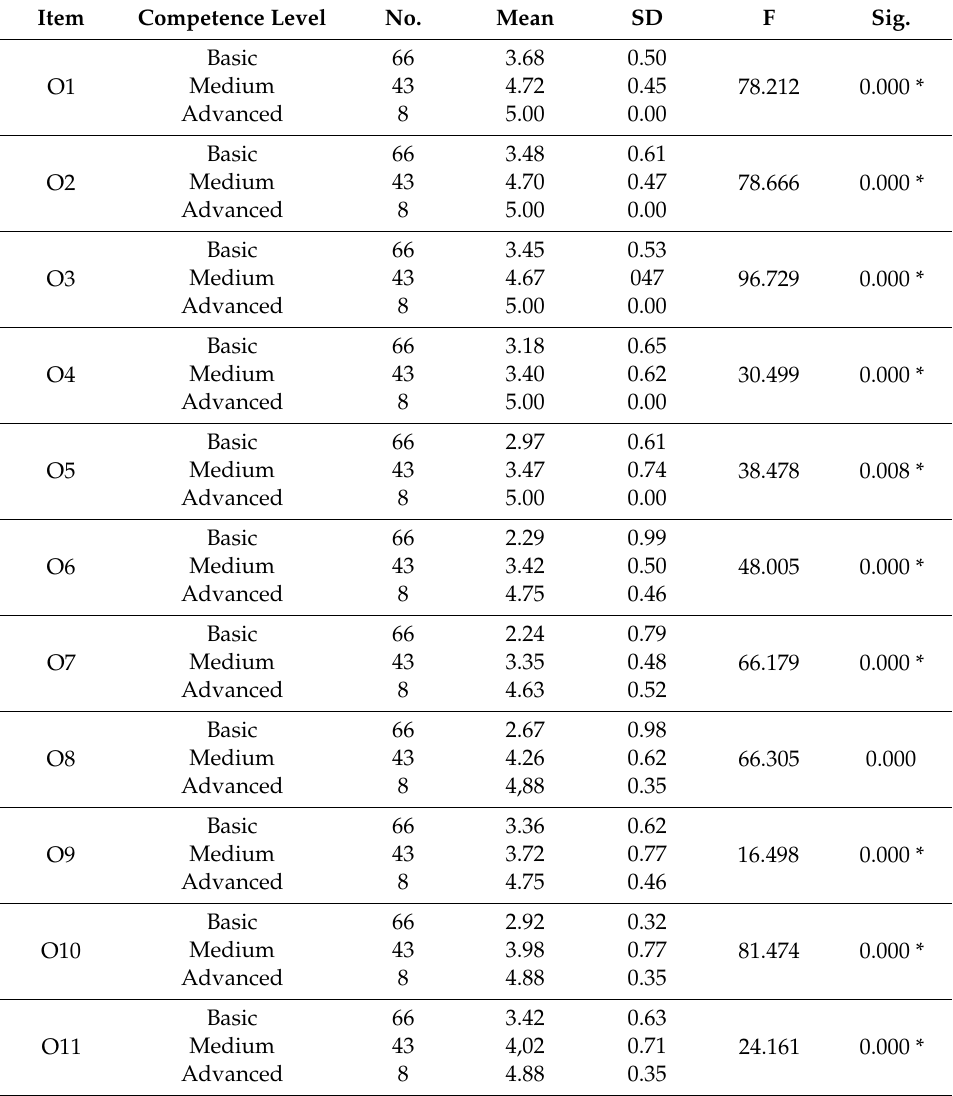
Table 5. Items with significant di ff erences depending on the Big Data competence variable.